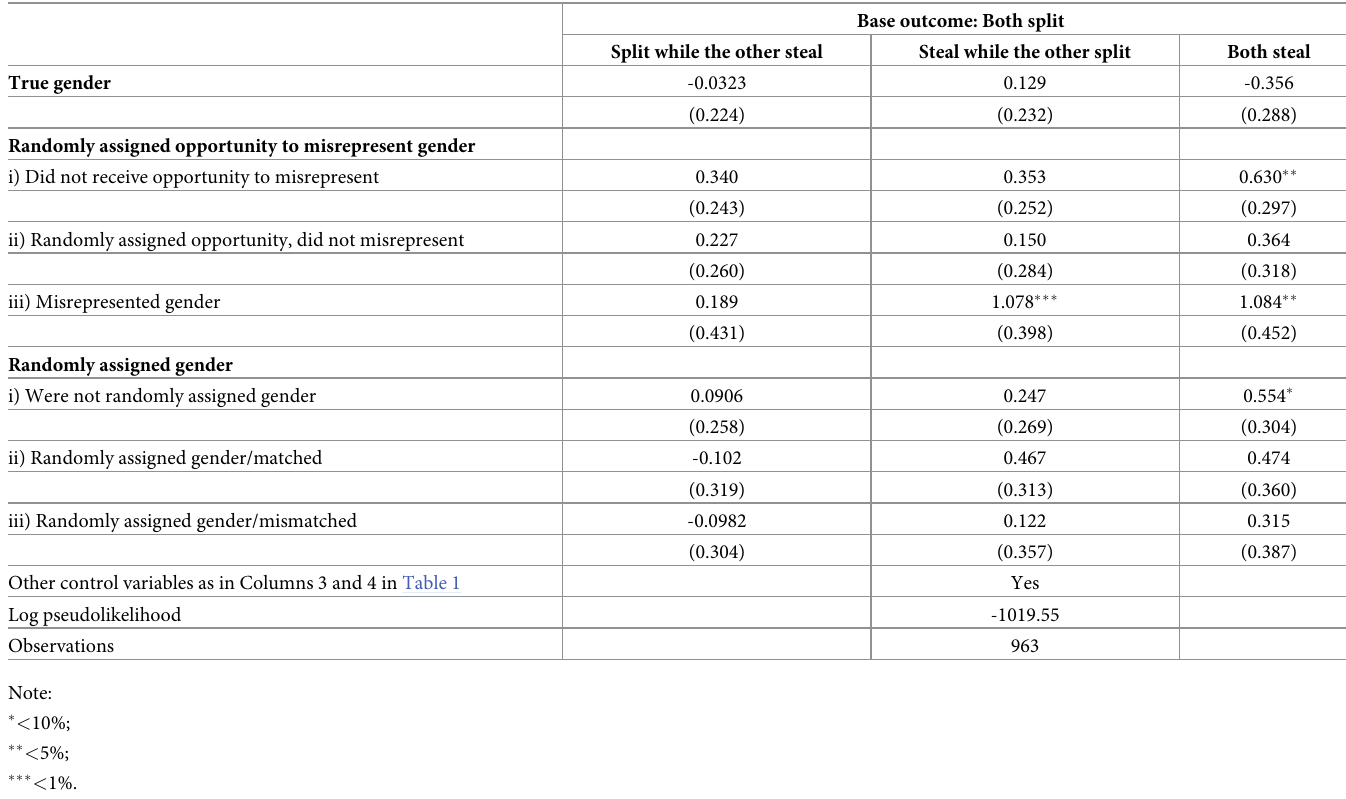
Table 5. Unpacking the treatment effects on the paired decision-making: Multinomial probit